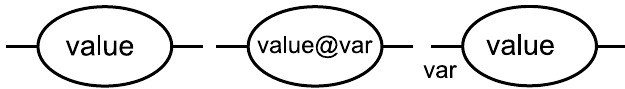
Figure 2.3: Examples of the Process Description glyph for state variable .